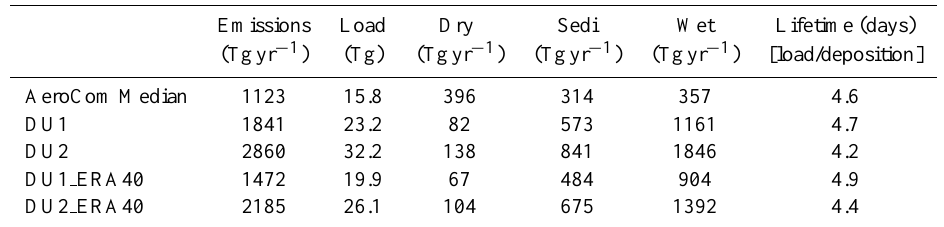
Table 5. Atmospheric dust budgets by the different emissions schemes, compared with the AeroCom median values as presented in Huneeus et al. (2011).